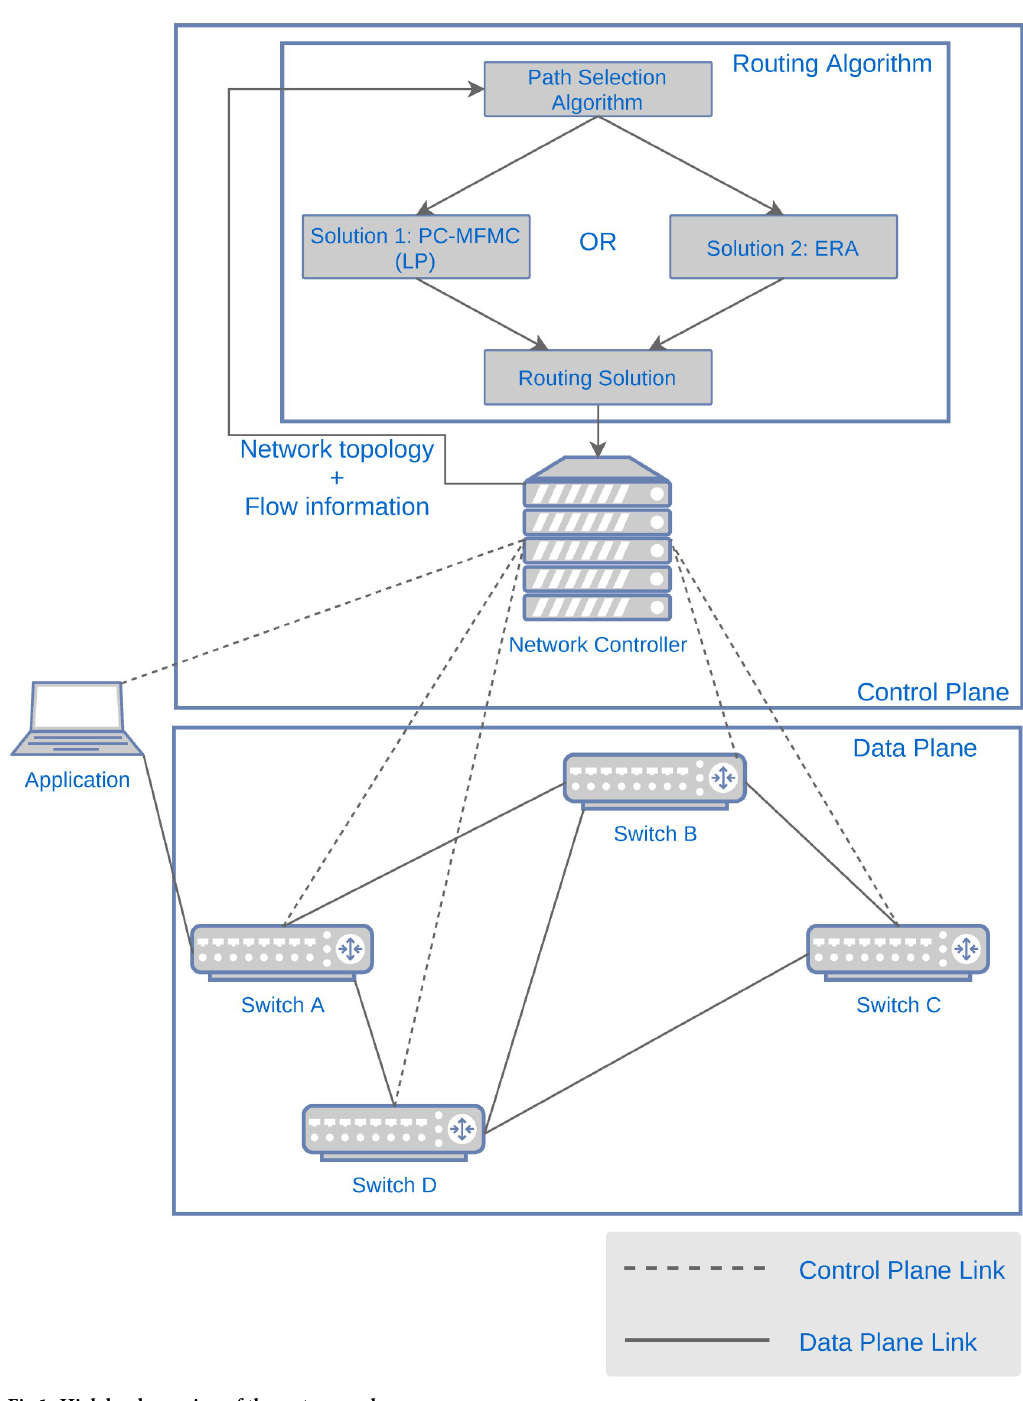
Fig 1. High level overview of the system